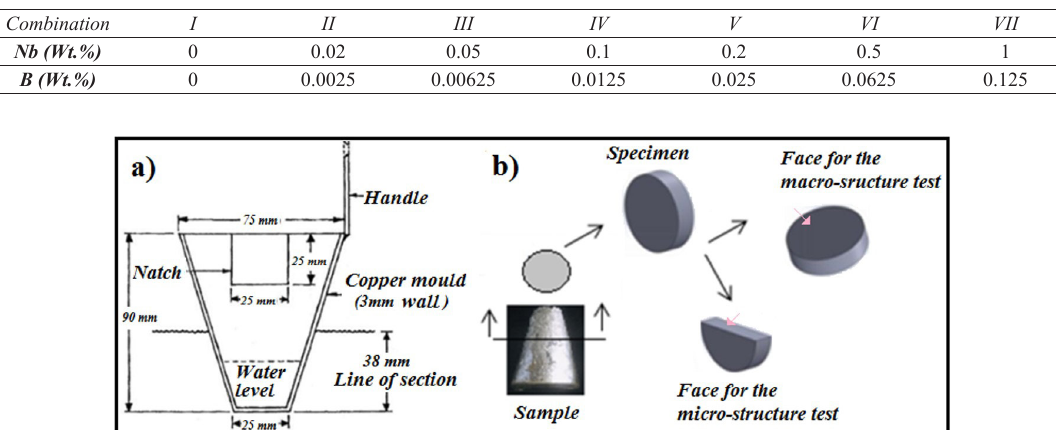
Figure 2. Illustrative sketch. a) Mould ladle. b) Cut the sample.